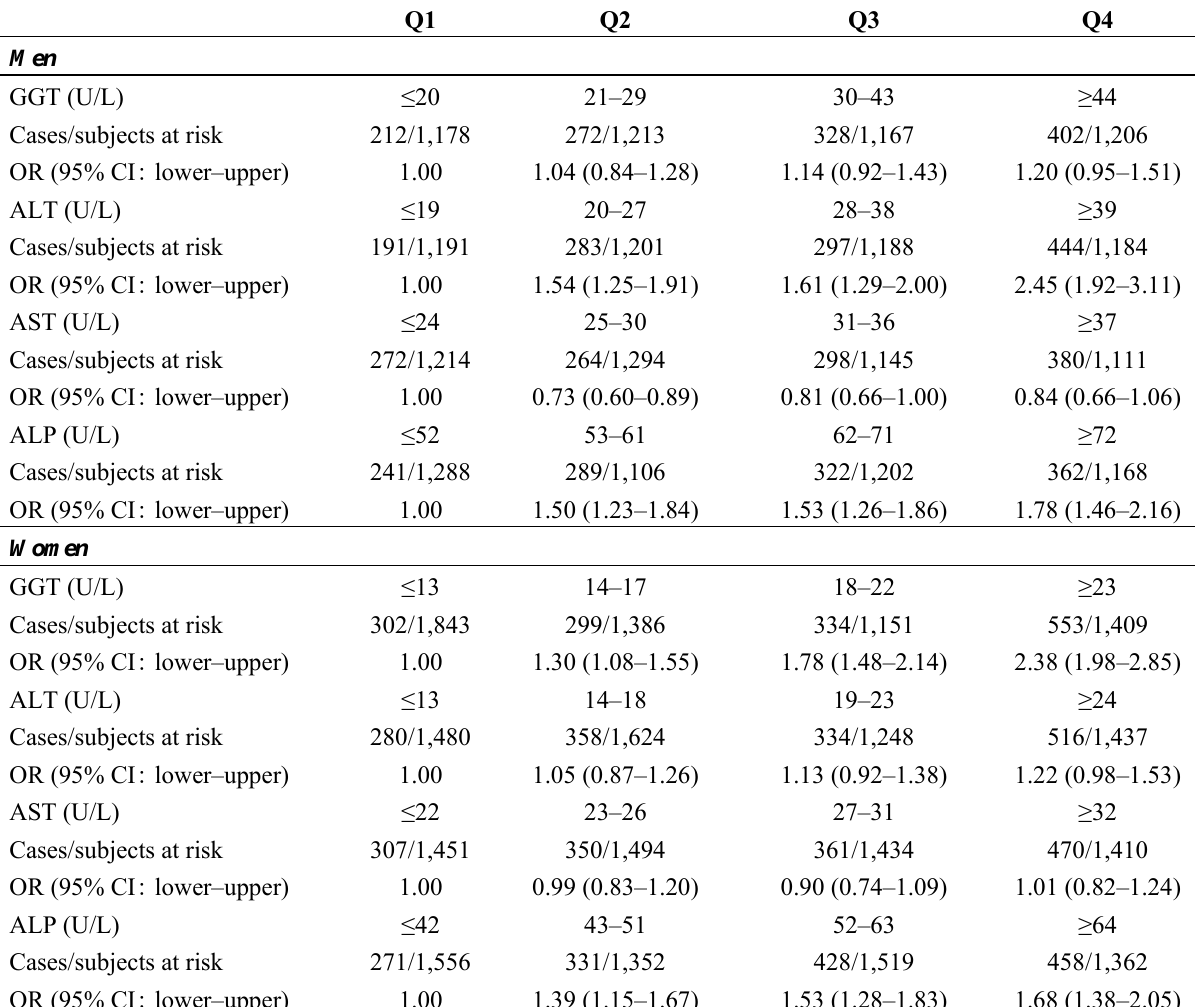
Table 6. Factors associated with reduced HDL-C by gender.